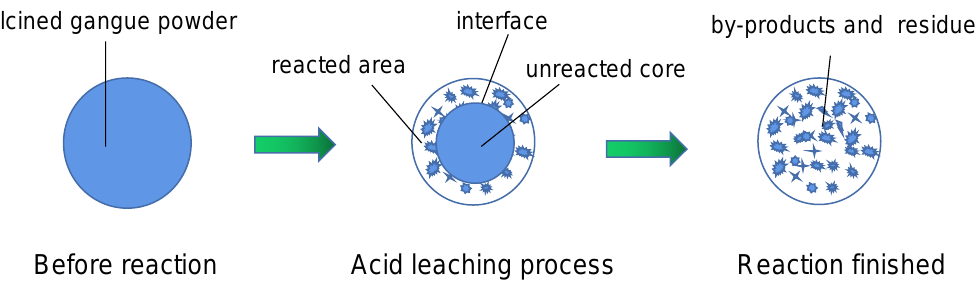
Figure 11. Schematic diagram of acid leaching process.